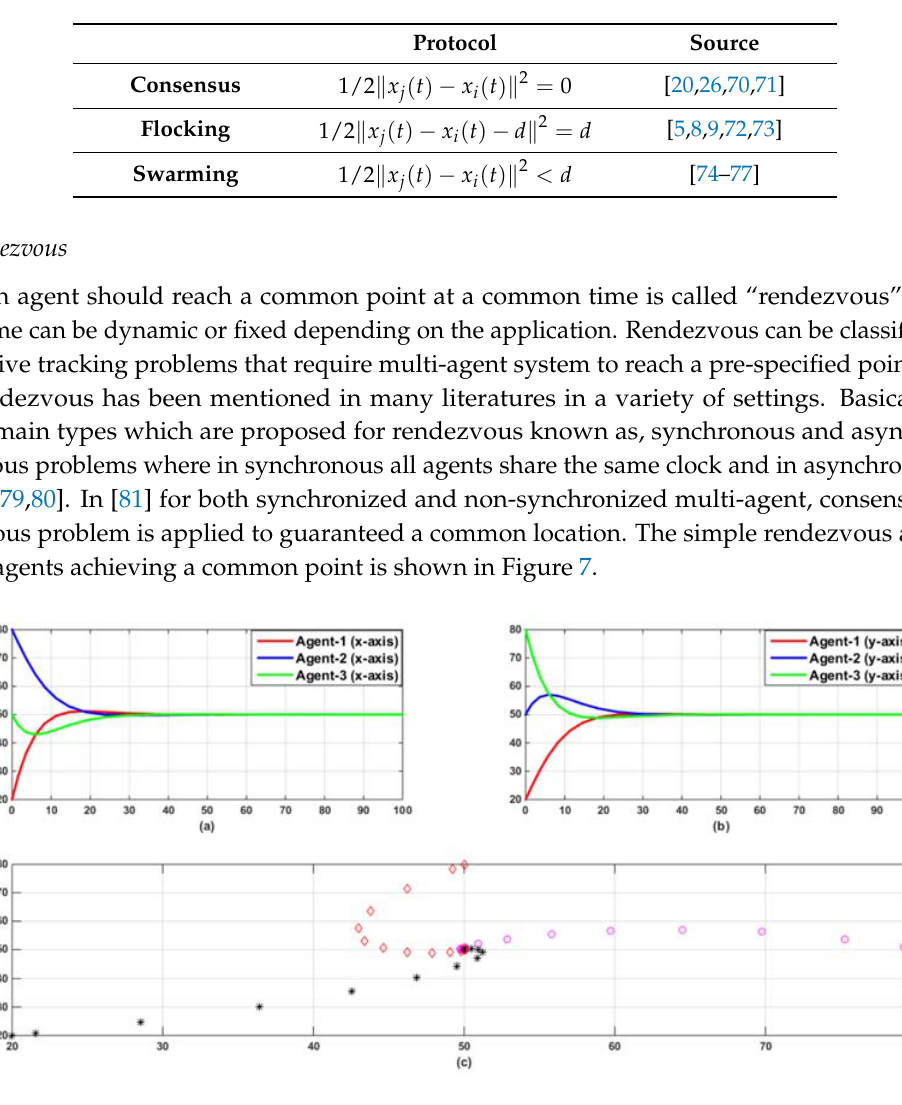
Figure 7. Rendezvous algorithm for 3 ‐ agents. ( a ) x ‐ axis vs time ( b ) y ‐ axis vs time ( c ) x ‐ axis vs y ‐ axis.